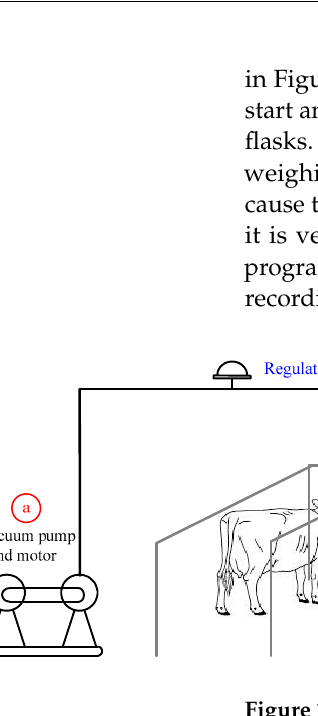
Figure 1. Bucket milking machine: two milking units.